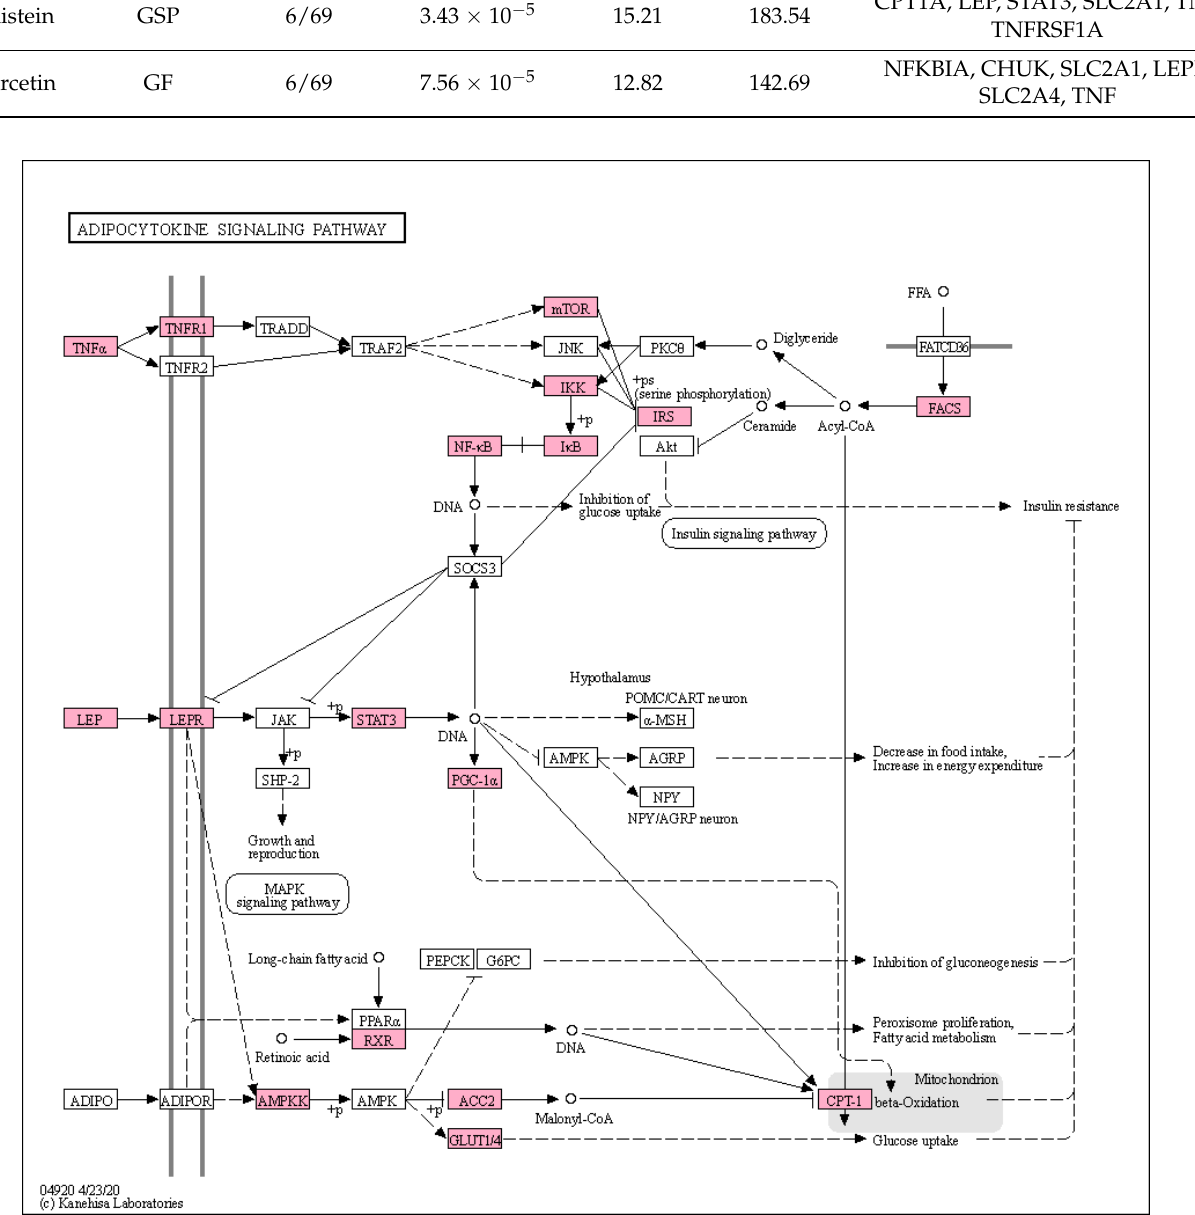
Figure 1. Adipocytokine signaling pathway and targets of AMGB, visualized by KEGG mapper. Boxes represent proteins that compose the adipocytokine signaling pathway. The pink-colored boxes represent targets of compounds of AMGB which are significantly associated with the adipocytokine signaling pathway.